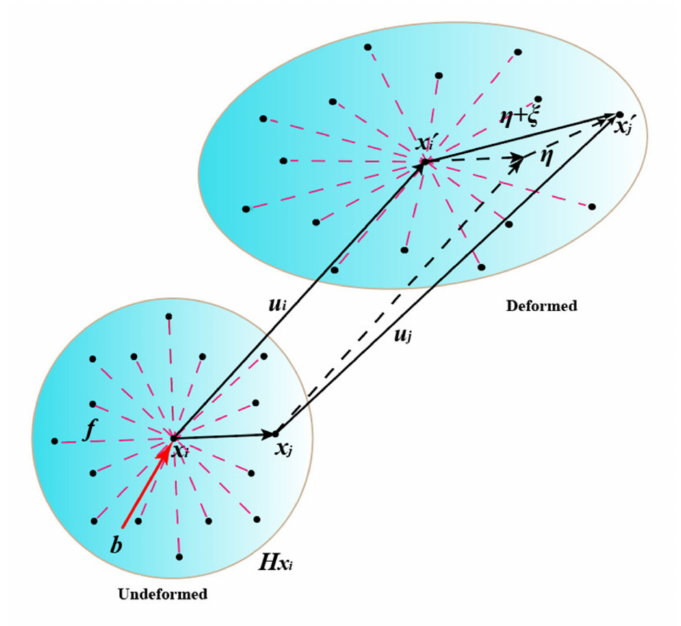
Figure 1. The peridynamic analysis of the movement of matter